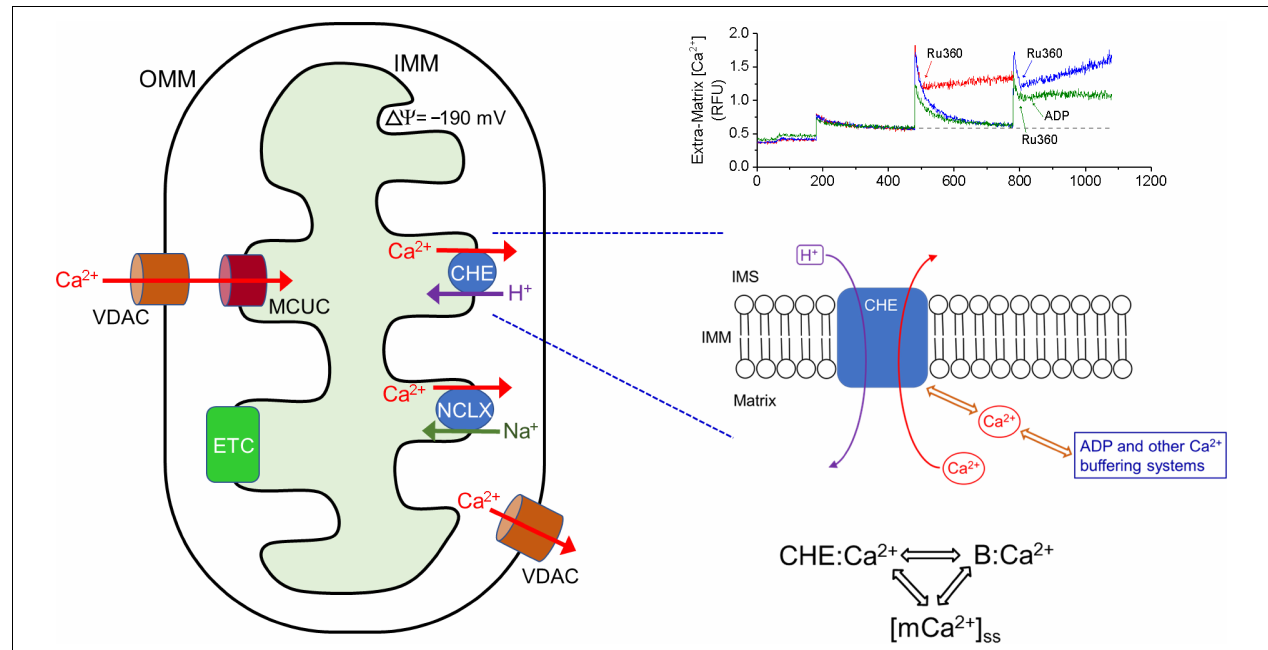
FIGURE 9 | Ca 2 + efflux via CHE is sensitive to total matrix Ca 2 + . Left: Representation of the principal influx and efflux pathways of mitochondrial Ca 2 + . OMM: Outer Mitochondrial Membrane, VDAC: Voltage-Dependent Anion Channel, IMM: Inner Mitochondrial Membrane, ETC: Electron Transport Chain, MCUC: Mitochondrial Calcium Uniporter Complex, NCLX: Na + -Ca 2 + -Li 3 + -Exchanger, CHE: Ca 2 + /H + Exchanger. Bottom Right: Proposed scheme for the activation of CHE by total matrix Ca 2 + . Ca 2 + efflux rate via CHE activation may be modulated by both the free steady-state matrix Ca 2 + and by the amount of Ca 2 + bound to other matrix buffering agents. By this scheme, the rate of Ca 2 + efflux via CHE will increase as steady state matrix Ca 2 + increases or when buffering capacity is exceeded. CHE:Ca 2 + denotes Ca 2 + bound to the CHE protein, B:Ca 2 + denotes Ca 2 + bound to matrix buffering agents such as ADP, [mCa 2 + ] ss denotes steady-state matrix free Ca 2 + concentration. Top Right: Superimposed traces of extra-matrix Ca 2 + , adapted from Figure 1A , showing the different rates of Ca 2 + efflux, when Ru360 is applied after addition of one Ca 2 + bolus (red) or two CaCl 2 boluses (blue) or two CaCl 2 boluses and addition of ADP 20 s after Ru360 (green). In all three cases, the starting baseline Ca 2 + was the same and the applied CaCl 2 bolus was the